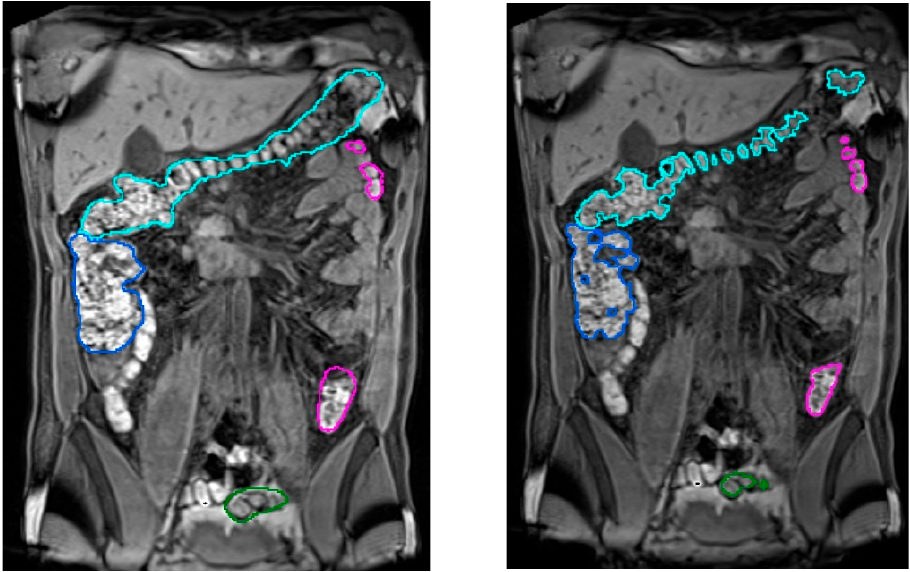
Figure 5. Comparison of segmentation results in a T1-FS coronal slice. In the left image, the original slice visualized with the corresponding automatic colon segmentation outlined using a different color for each of its segments. In the right image, the same coronal slice is visualized with the corresponding manual identification of the fecal content, used as a ground truth in the validation